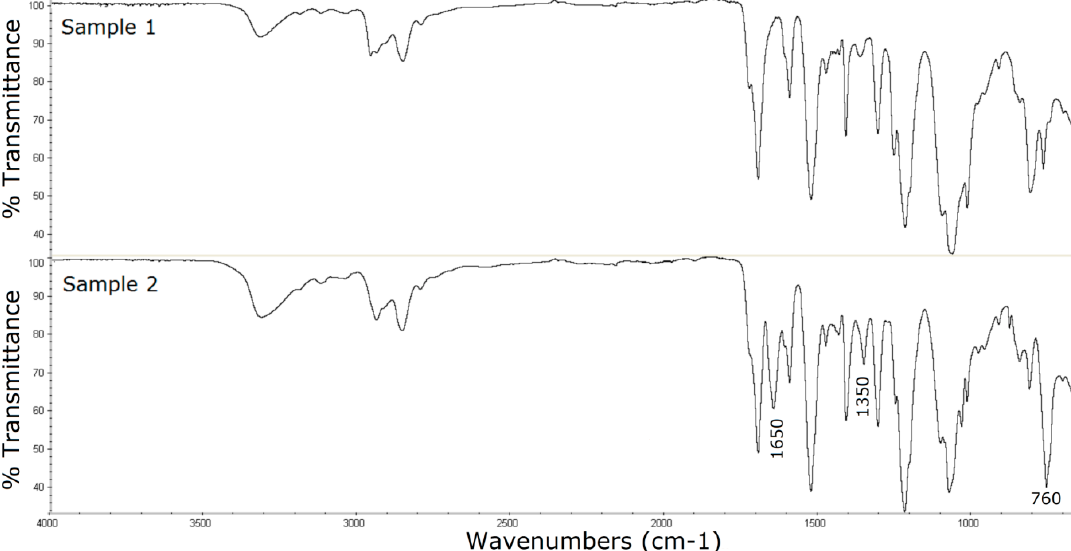
Figure 2. Fourier transform infrared spectroscopy (FTIR) spectra of the untreated polyurethane catheter ( Sample 1 ) and P-2-CA-treated catheter with the formation of porphyrin ( Sample 2 ).